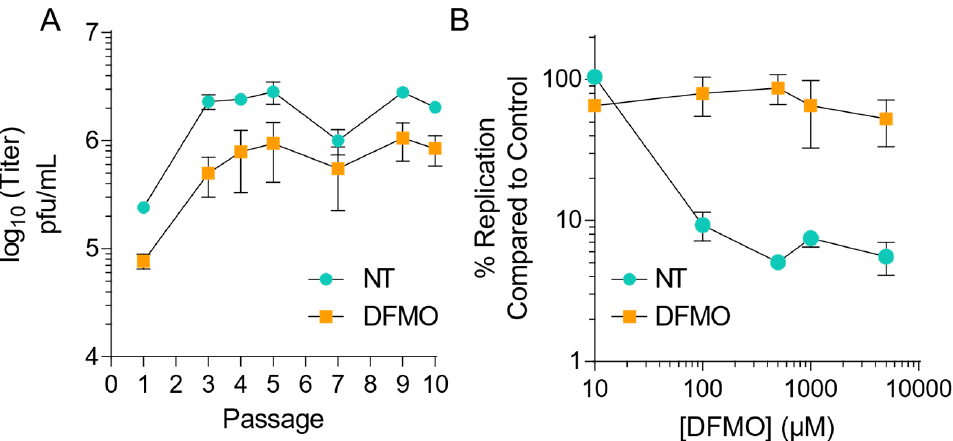
Figure 1. CVB3 gains resistance to polyamine depletion over passage with difluoromethylornithine. ( A ) Vero-E6 cells were left untreated or treated with 500 µM DFMO for four days prior to infection with CVB3 at MOI 0.1. Virus was collected at 24 hpi and used to inoculate the next passage. Viral titers were determined by plaque assay for the passages as shown. ( B ) CVB3 passaged five times over Vero-E6 cells, either treated with 500 µM DFMO or untreated, were used to infect Vero cells treated with increasing doses of DFMO for 24 hpi. Viral titers were determined by plaque assay. Error bars represent ± 1 SEM.